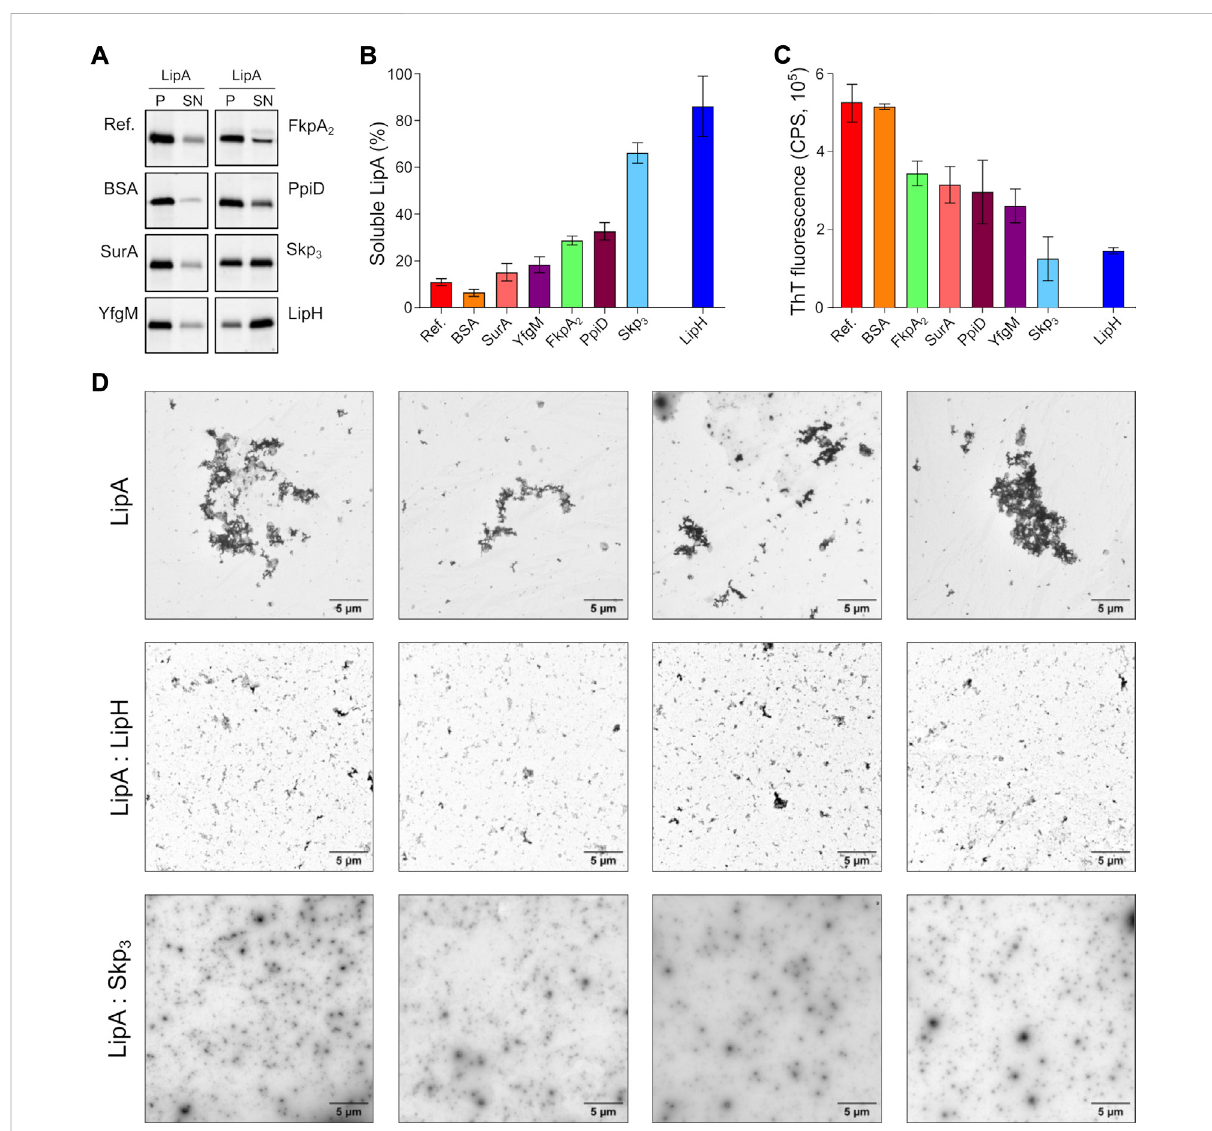
FIGURE 4 The periplasmic chaperone Skp rescues LipA from aggregation. (A) LipA solubility in the presence of the periplasmic chaperones. The aggregated and soluble LipA fractions are separated in pellet (P) and supernatant (SN) fractions in the sedimentation assay and visualized on SDS- PAGE via in-gel fl uorescence. The supplemented chaperones are indicated. Bovine serum albumin (BSA) was used as a negative control. LipA in absence of chaperones is indicated as “ Ref. ” . (B) Quanti fi cation of the soluble LipA in the presence of the periplasmic chaperones from SDS- PAGE (panel A). The assays were performed in technical triplicates, the mean values and SD are shown. (C) The periplasmic chaperones suppress formationofLipA β -structuredaggregates.ThT fl uorescencewasrecordedforthewild-typeLipAinthepresenceoftheperiplasmicchaperones,and the fl uorescencemeasuredforthechaperonesalonewassubtracted.Theassayswereperformedintechnicaltriplicates,themeanvaluesandSDare shown. (D) LipA aggregation in presence and absence of LipH (LipA:LipH) or Skp (LipA:Skp 3 ) visualized via negative-stain TEM. Scale bars are indicated.The relativelylow contrastrepeatedly observed